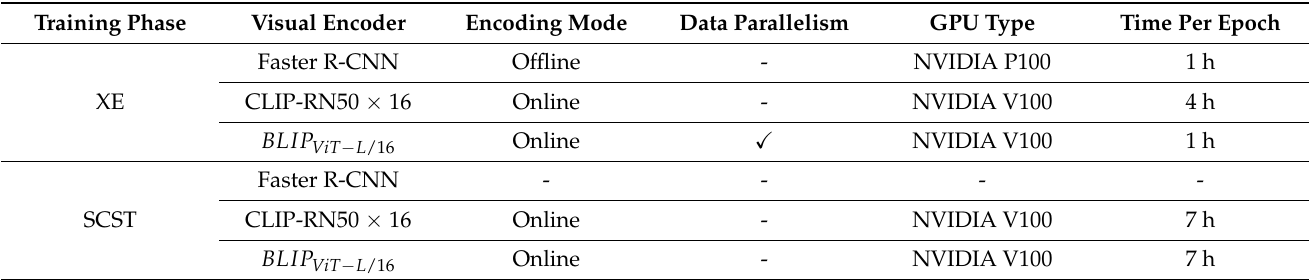
Table 3. Training time based on utilizing different visual encoding modes.